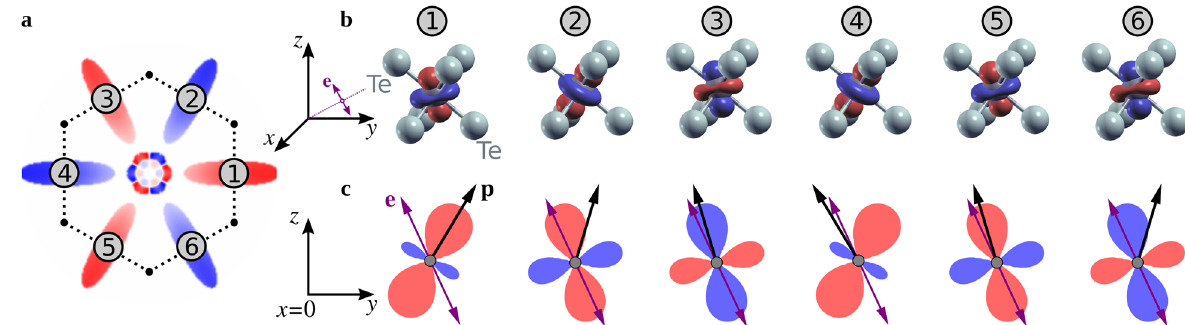
Fig. 7 Physical origin i LDAD: momentum-dependent orbital orientation. a Sketch of the calculated (TB + PW) i LDAD with labeled M/M' pockets (1 – 6). b Sketch of the hybrid orbital e ψ m ð r Þ , for each M/M' points shown in ( a ). The orbital is represented by the constant-value contour j e ψ m ð r Þj ¼ 0 : 02 , while the red (blue) color shading indicates Re ½ e ψ m ð r Þ(cid:7) > 0 ( Re ½ e ψ m ð r Þ(cid:7) < 0 ). The coordinate systems corresponds to the laboratory frame. c projection of the hybrid orbitals onto the x – z plane. The photoelectron wave vector p is indicated by the black